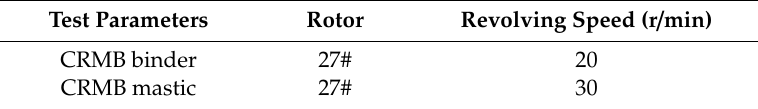
Table 8. Test parameters of the CRMB binder and the CRMB mastic.